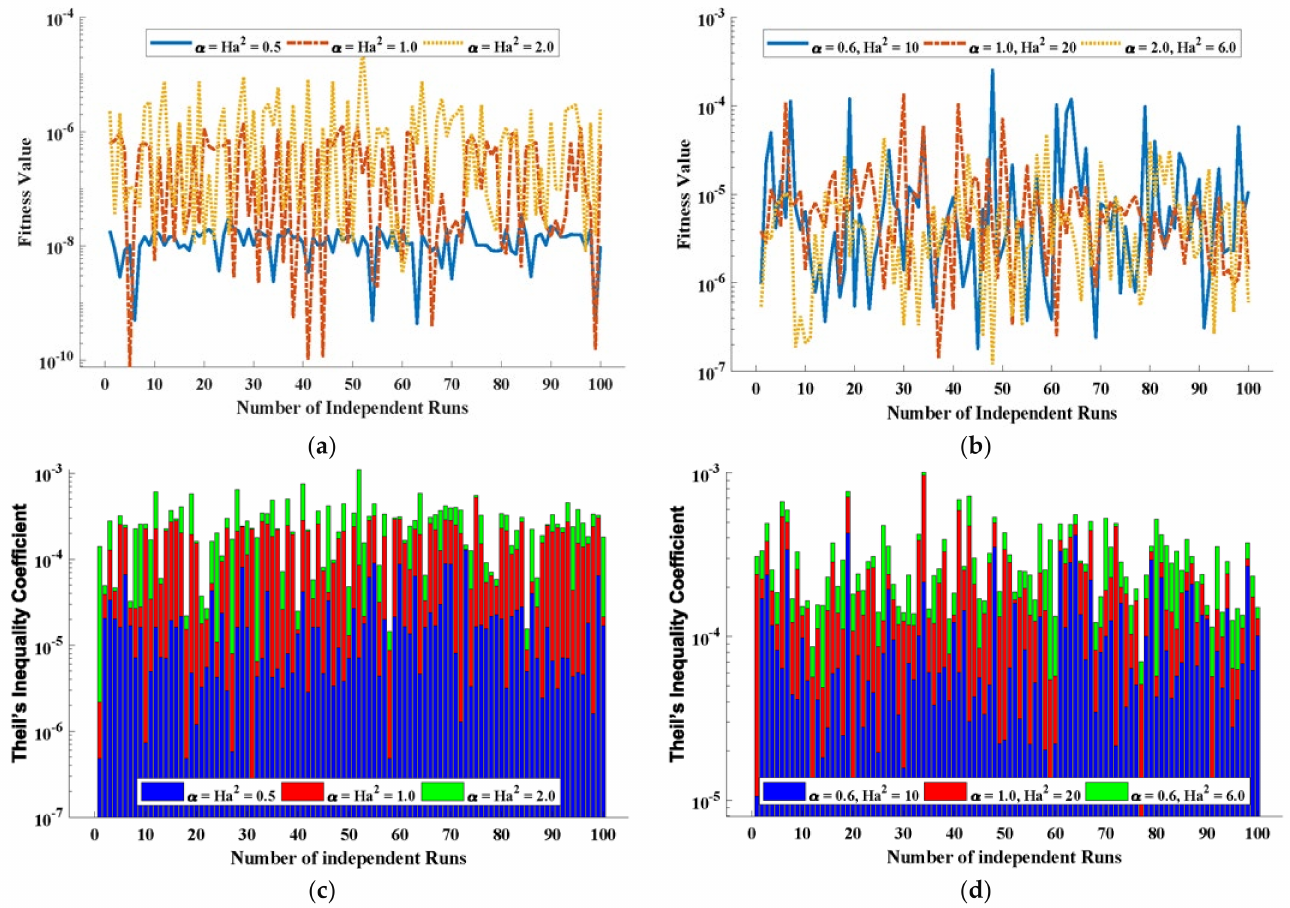
Figure 9. ( a , b ) shows the behavior of fitness value and ( c , d ) represents the convergence of the value of TIC during the optimization procedure of Equation (17), by the ANN-GNDO-SQP algorithm.